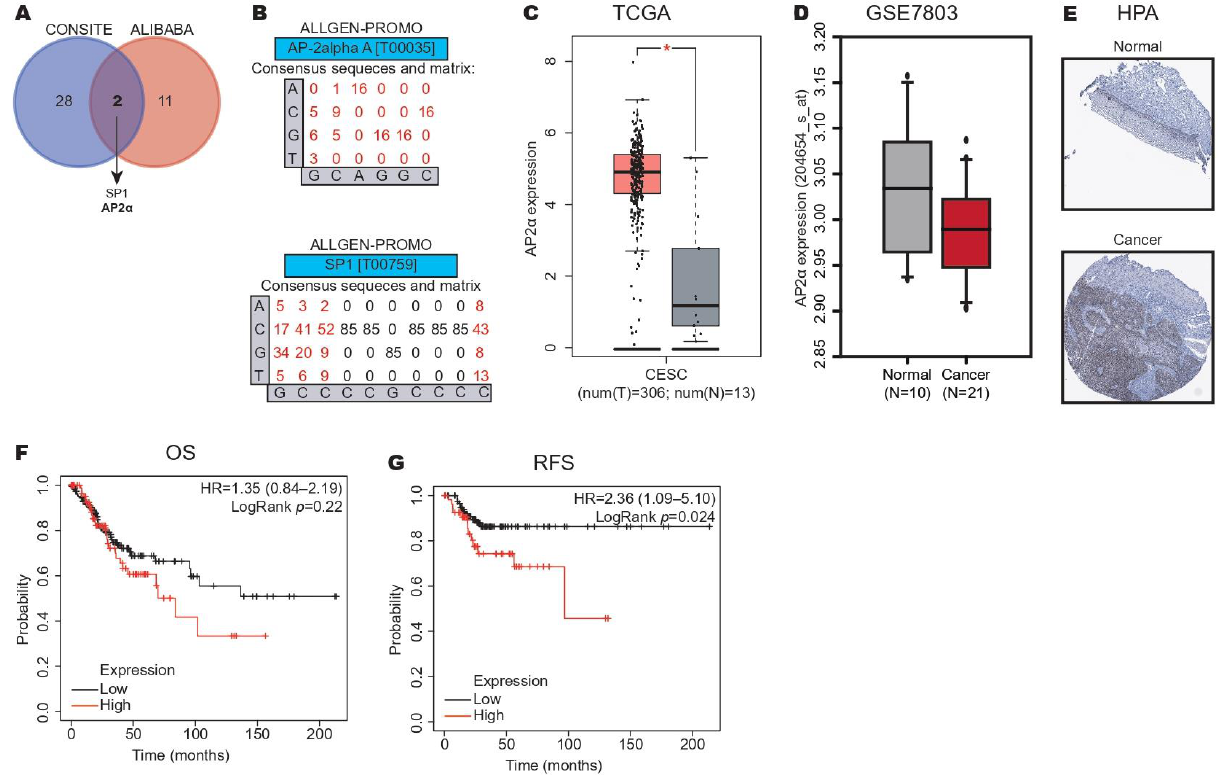
Figure 4. AP2 α expression increases in cervical cancer. ( A ) Identification of binding sites for the SP1 and AP2 α transcription factors in the FLI1 promoter using the CONSITE and ALIBABA databases. ( B ) Validation of binding sites for SP1 and AP2 α transcription factors in the FLI-1 promoter using the ALLGEN-PROMO database. ( C ) AP2 α expression in the CC and normal tissue samples from the TCGA dataset. ( D ) AP2 α expression in the CC and normal tissue samples from the GSE7803 dataset. ( E ) AP2 α expression in the CC and normal tissue samples from the HPA dataset. ( F ) Kaplan–Meier curves of OS according to AP2 α expression in the CC samples of patients with CC from the TCGA dataset. ( G ) Kaplan–Meier curves of RFS according to AP2 α expression in the CC samples of patients with CC from the TCGA dataset. * p -value <